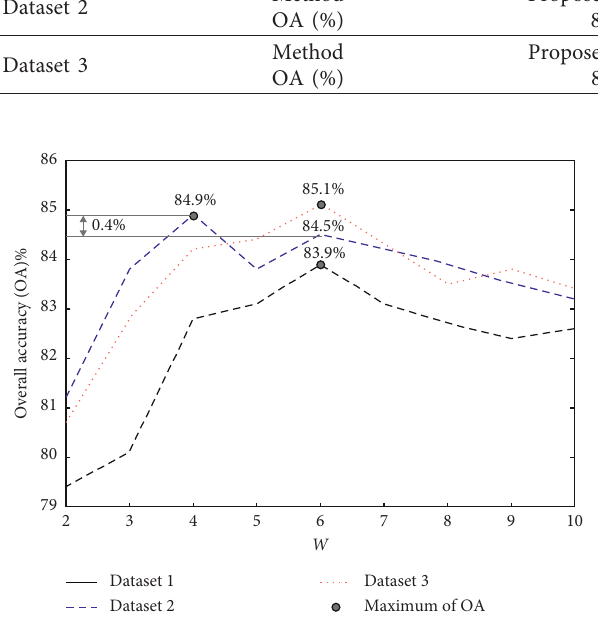
Figure 9: Analysis of the impact on OA with different W